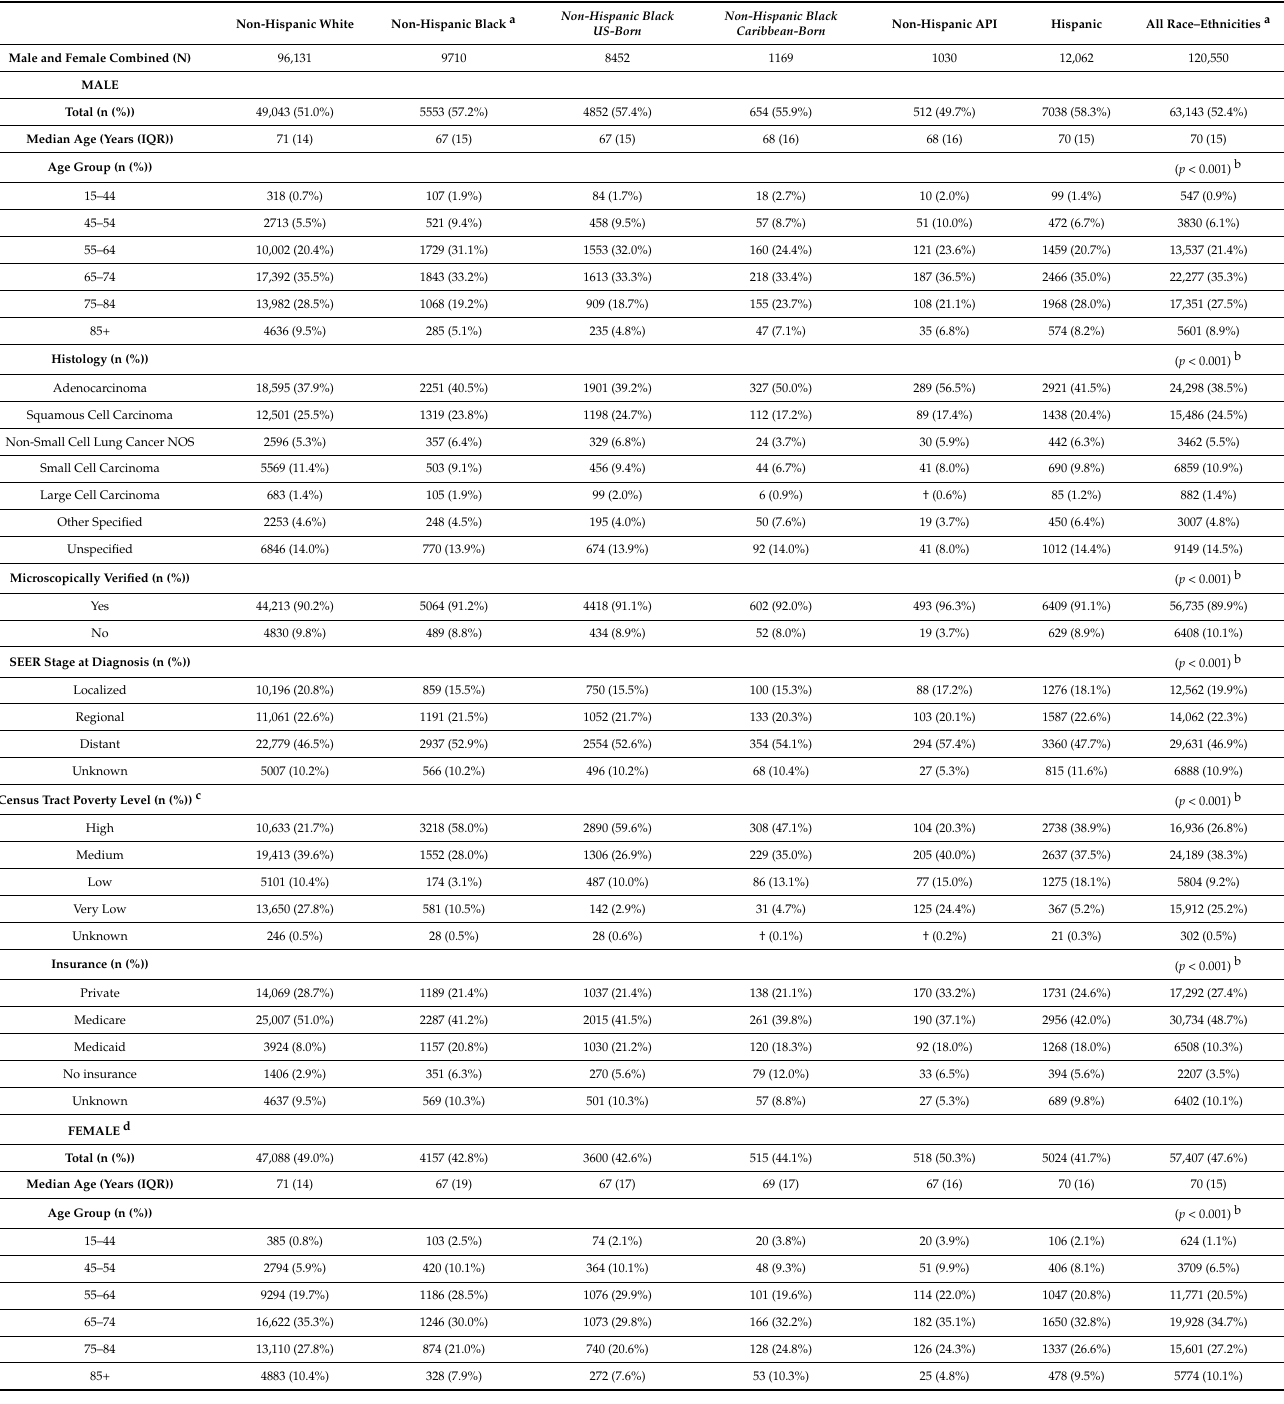
Table 1. Demographic and Clinical Characteristics of Lung Cancer Cases by Race–Ethnicity and Non-Hispanic Black Detailed Race–Ethnicity and Sex. Florida,